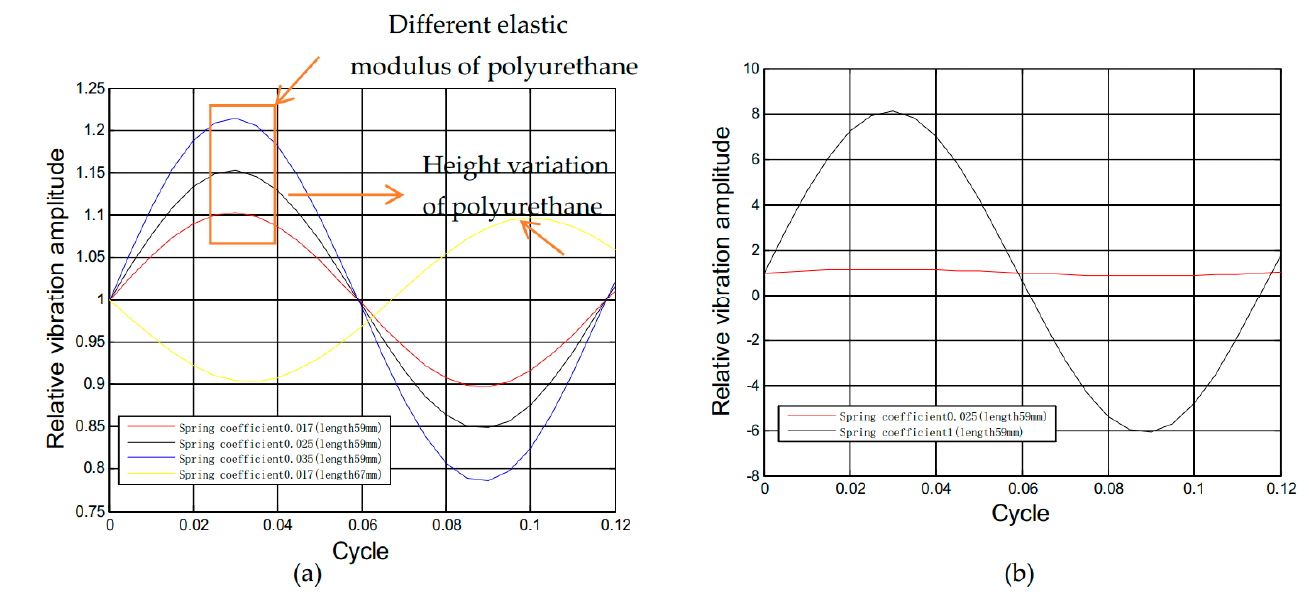
Figure 6. First-order mode of fiber lasers’ amplitude ( a ) First-order mode of fiber laser with flexi- ble fixation varies with the parameters ( b ) First-order modes of fiber lasers in different fixed